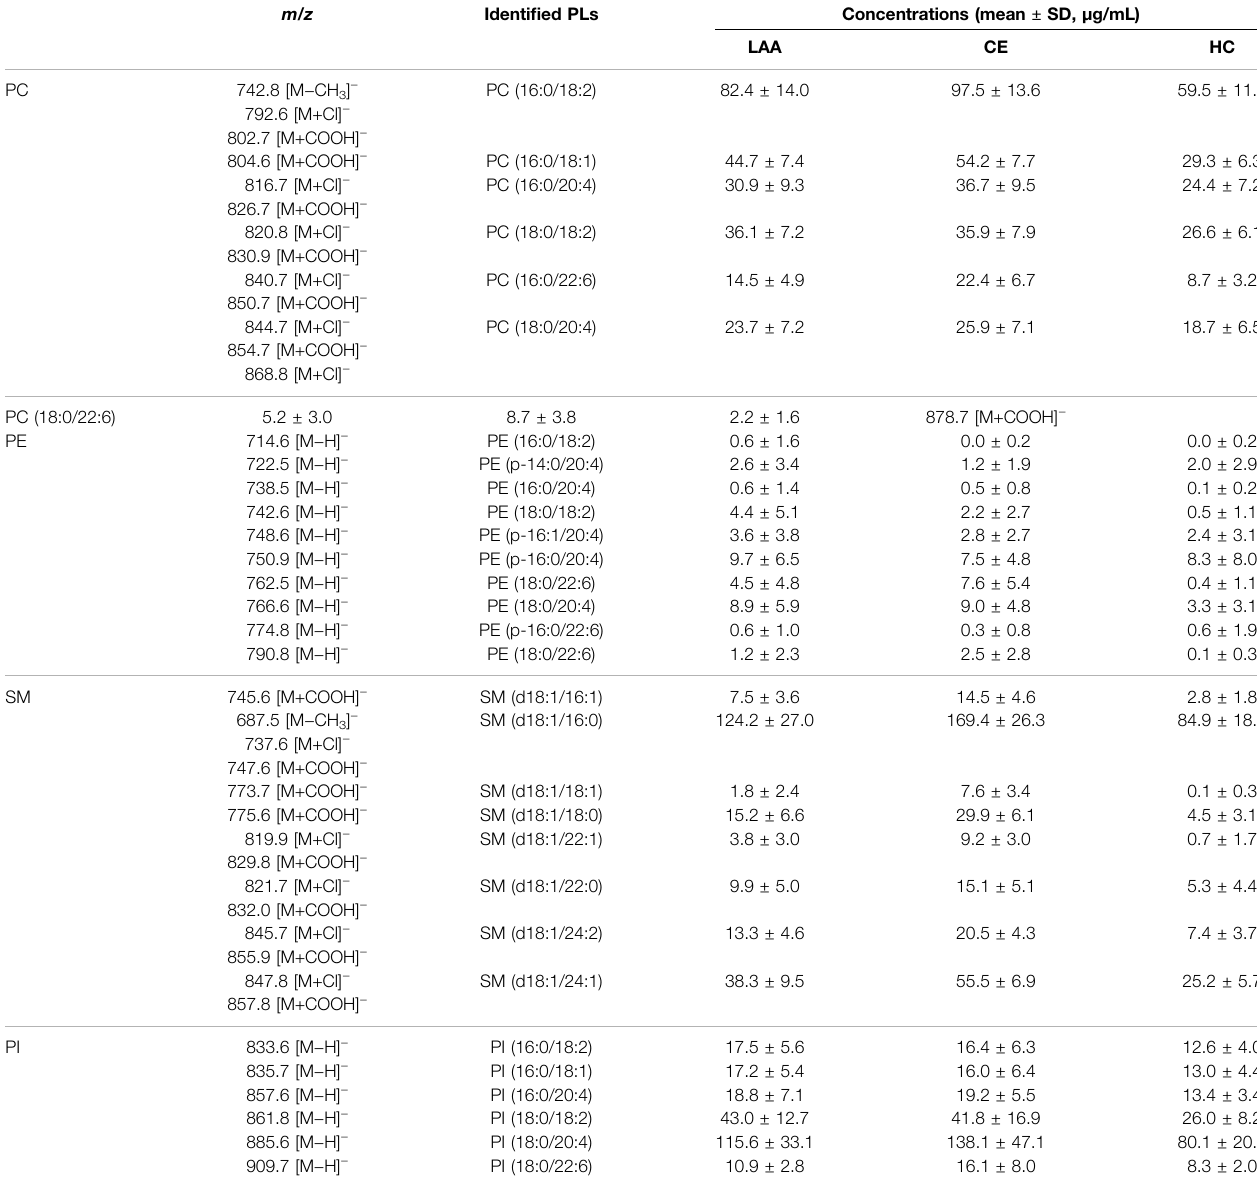
TABLE 2 | The characterized molecular species of PLs and their concentrations in human plasma. m/z Identi fi ed